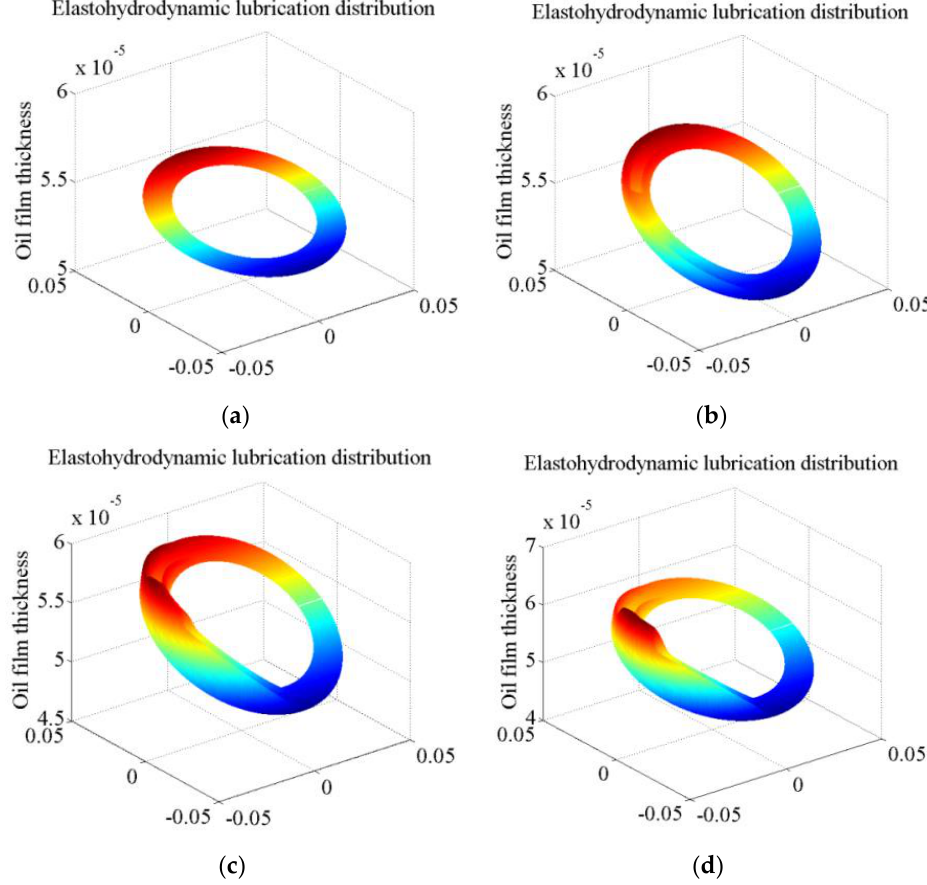
Figure 10. Effect of the angle of inclination on the oil film clearance under elastic deformation. ( a ) φ = 0.002°; ( b ) φ = 0.004°; ( c ) φ = 0.006°; ( d ) φ = 0.008°.